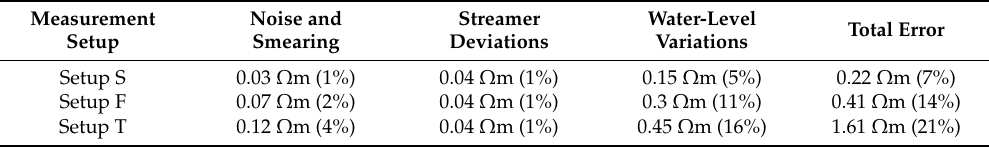
Table 4. Measurement errors resulting from noise, streamer deflections and water-level variations are estimated for an electrode of L / 2 = 7 m and compared among the measurement